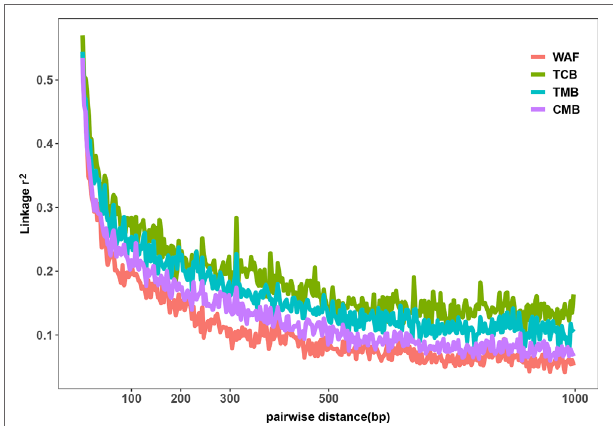
FIGURe 2 | Linkage disequilibrium (LD) decay in four regions. LD decay was measured by r 2 between pairs of markers with MAF >2% and within 1,000